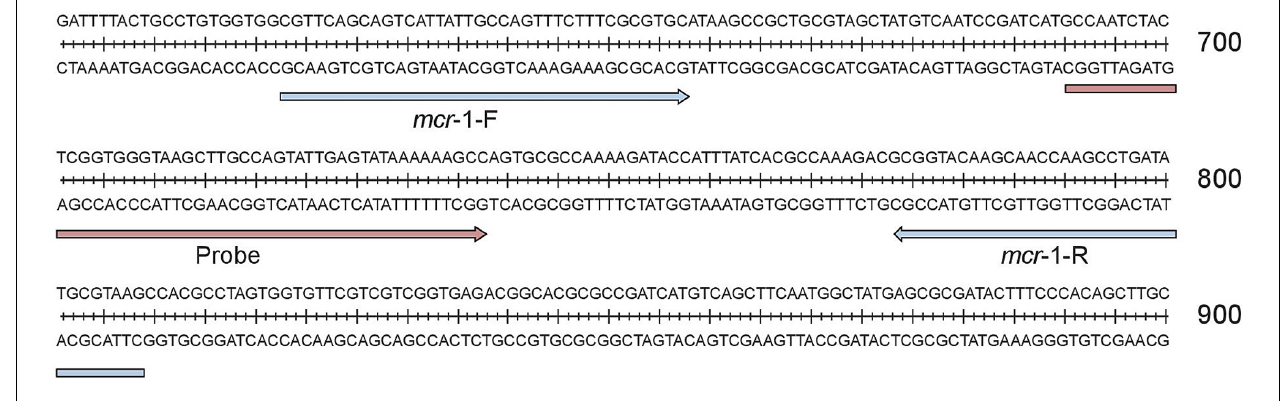
FIGURE 1 | Primer and probe regions in mcr -1.